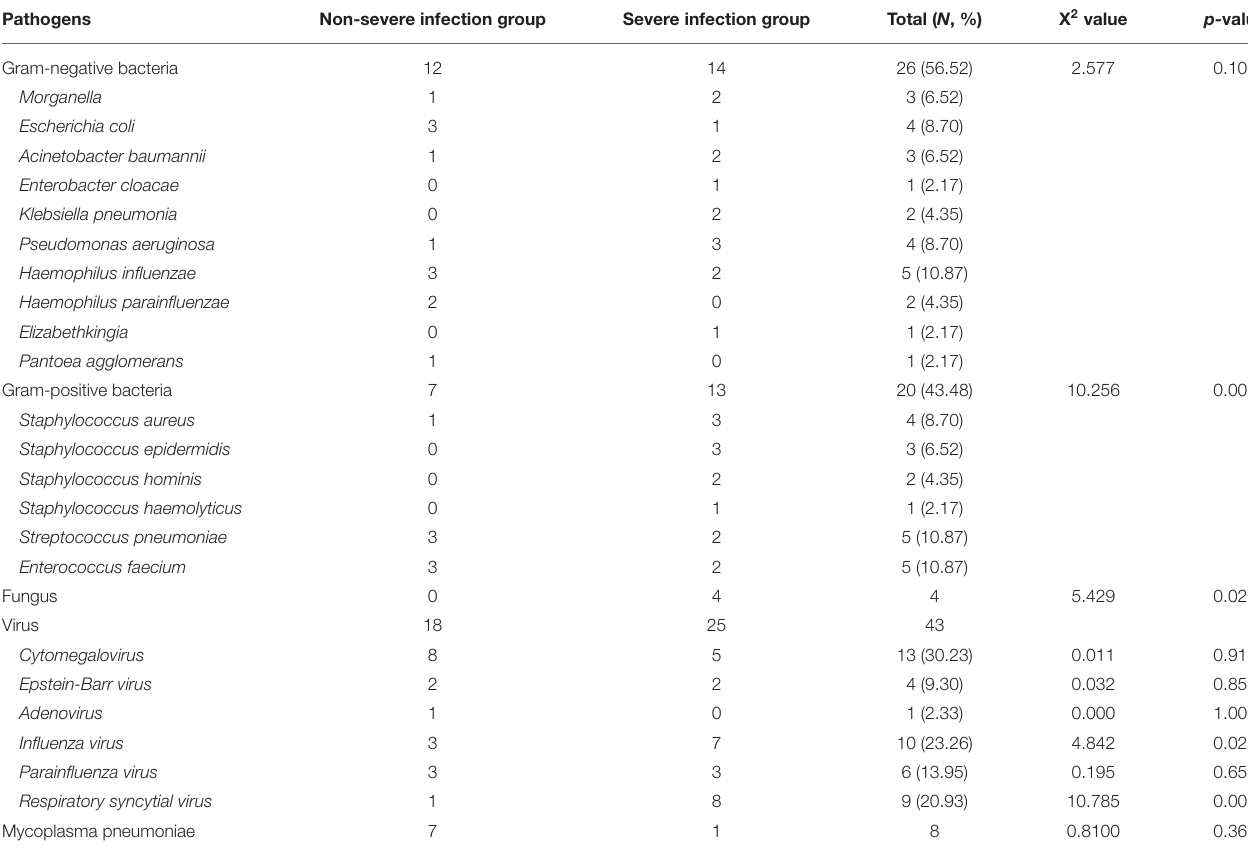
TABLE 4 | Pathogen spectrum and the analysis in the severe and non-severe infection group.